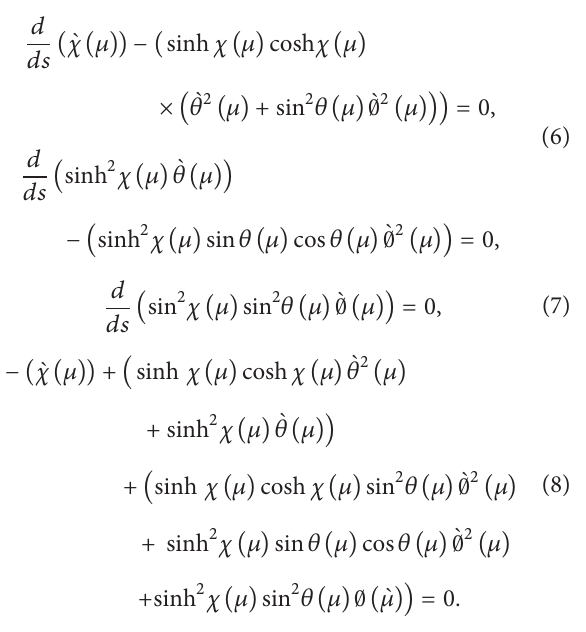
the upper hypermanifolds ∃ for every corresponding points, that is, 𝜇(𝑎 𝑖 ) = 𝜇(𝑎 𝑗 ) [15].